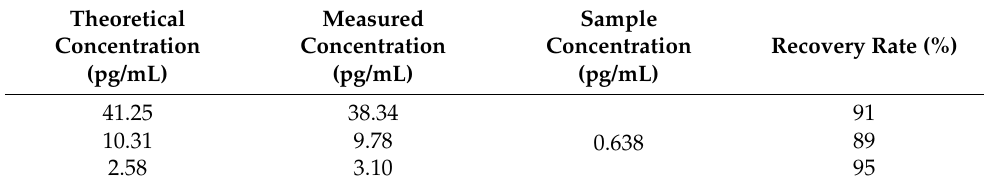
Table 2. Recoveries of PPI from the samples fortified with different amounts of PPI.